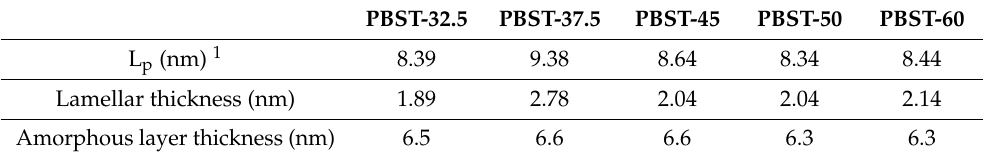
Figure 3. The SAXA curve and Lorentz-corrected SAXS profiles for the PBST with different BT contents. ( a ) The SAXA curve; ( b ) Lorentz-corrected SAXS profiles. Table 4. The long period (L p ) of PBST copolymer with different BT contents.